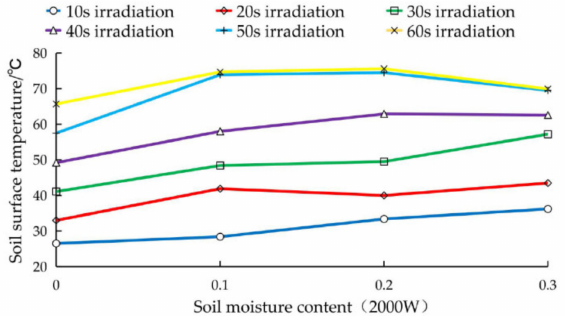
Figure 16. Change in soil moisture content and soil surface temperature (2000 W).